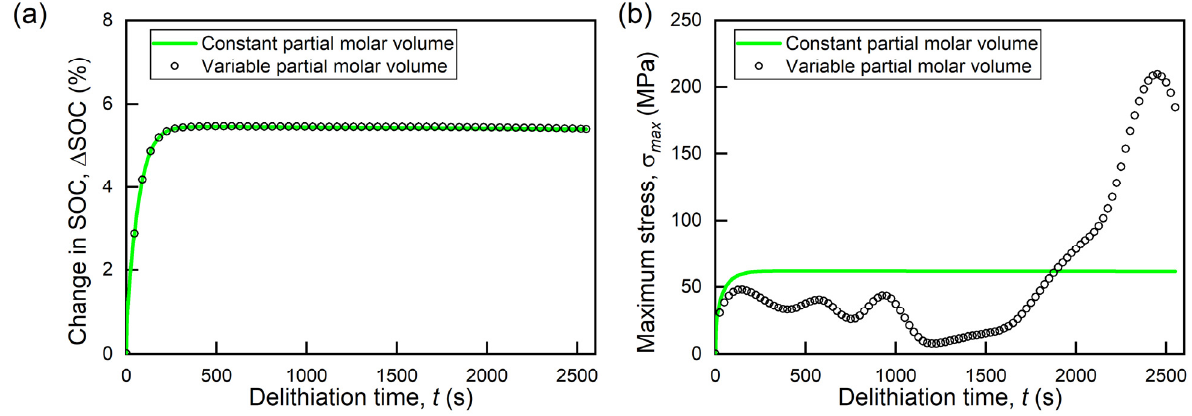
Figure 6. Comparison of results for uncoupled simulations. ( a ) The difference between the maximum and minimum local state of charges ( ∆ SOC). ( b ) The maximum value of the local first principal stress ( σ max ).